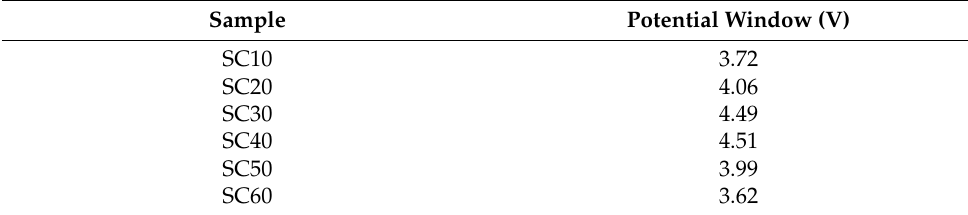
Table 4. Potential window values for MC/PC/K 3 PO 4 /glycerol